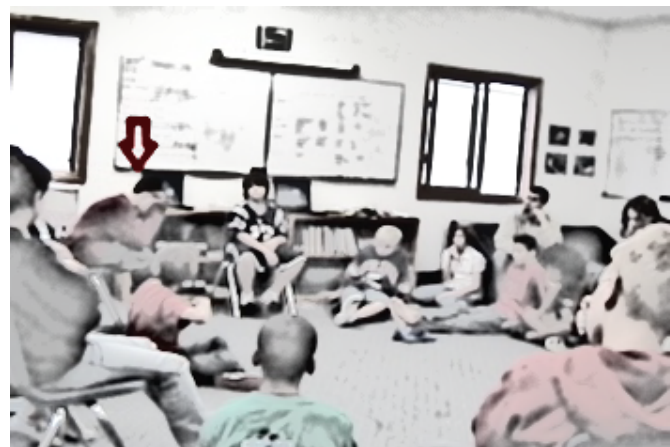
Figure 2: Group 3 Choices class, November, 10 2006: Andrew’s cathartic crying in response to Ben’s utterance. Andrew (underneath the arrow) has his head down, and is sobbing. Everyone appears to be directing their gaze at him, apparently expressing concern. While this scene is occurring, another student, George, has the floor, and is providing advice to